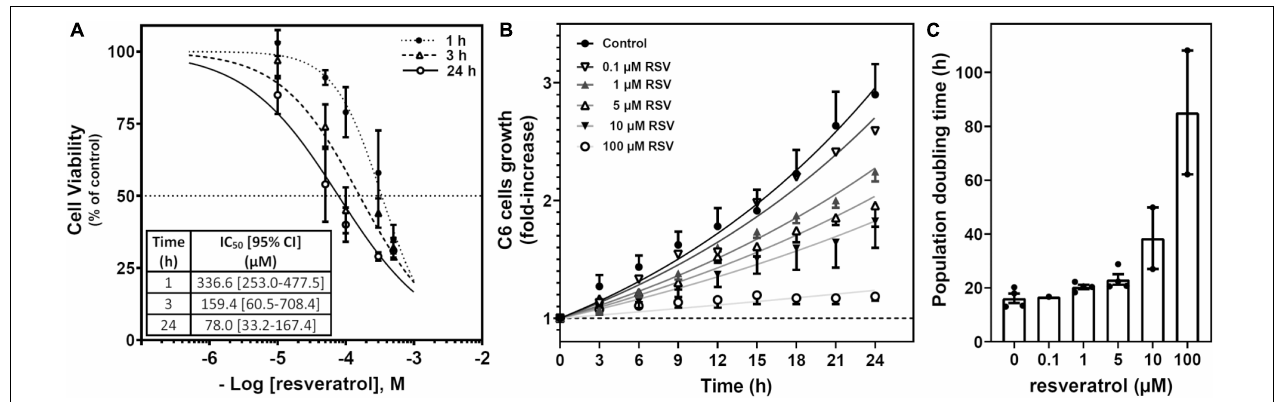
FIGURE 1 | Effect of RSV on C6 glioma cell growth. (A) Cell viability based on the XTT method was performed after RSV exposure for 1, 3, and 24 h at different concentrations. Data are means ± SEM of three to six independent assays. (B) Cells were treated with different concentrations of RSV as indicated. Cells were counted from phase-contrast images recorded (one frame every 2 min) for 24 h at the indicated interval and relativized to the number of cells at the beginning of treatment. A representative video can be seen in Supplementary Video 1 . (C) Population doubling time derived from three to five video recordings as represented in panel (B)